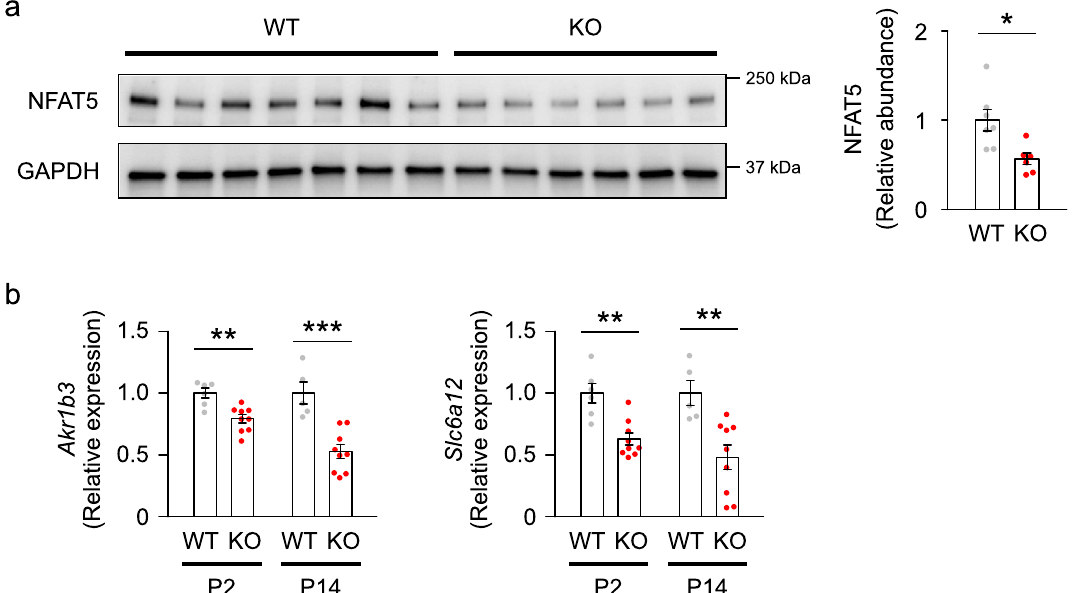
Figure 6. NFAT5 signaling is impaired in the kidneys of KO mice. ( a ) Immunoblots of NFAT5 in the kidneys of WT and KO mice at P14 ( n = 6–7 per group). ( b ) Quantitative analysis of the expression of Akr1b3 and Slc6a12 genes in the kidneys at P2 and P14 ( n = 5–7 per group). Protein and gene expression was normalized to a loading control protein (GAPDH) and a reference gene ( Rps29 ), respectively, and reported relative to the WT group at each time point. Statistical significance was analyzed by unpaired t test. * P < 0.05, ** P < 0.01, *** P <